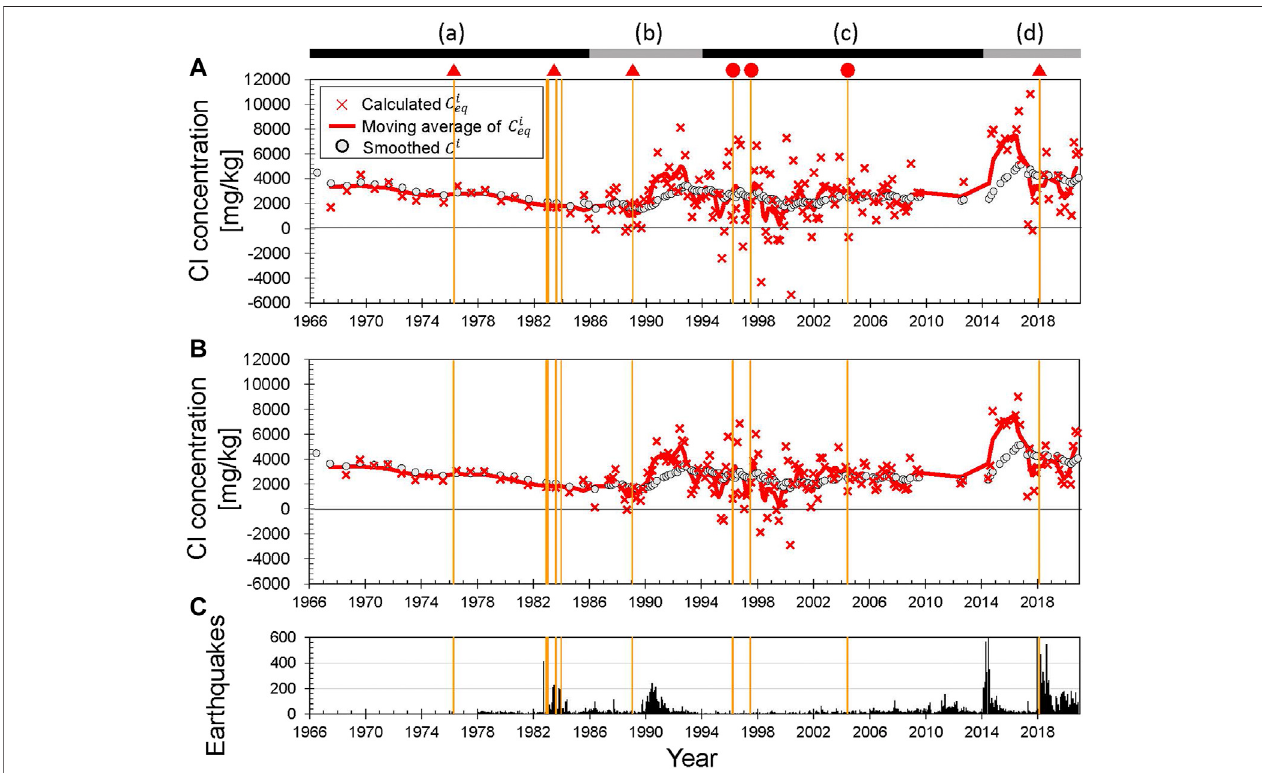
FIGURE 5 | Computational results for C i eq using (A) the two and (B) the three data calculation (red crosses) of Yugama crater lake at Kusatsu-Shirane volcano. SmoothedClconcentrationsareshownasgraycircles.(a – d)representtheperiodsde fi nedin estimationsofC i eq . (C) Monthlynumbersofearthquakes,whichisthesame as Figure 4B